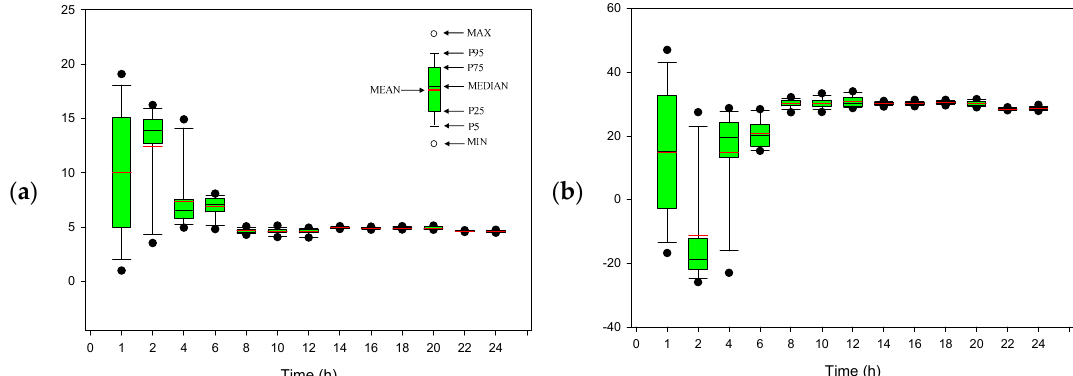
Figure 10. Initial ( a ) and updated ( b ) traffic noise prediction curves in scenario B.